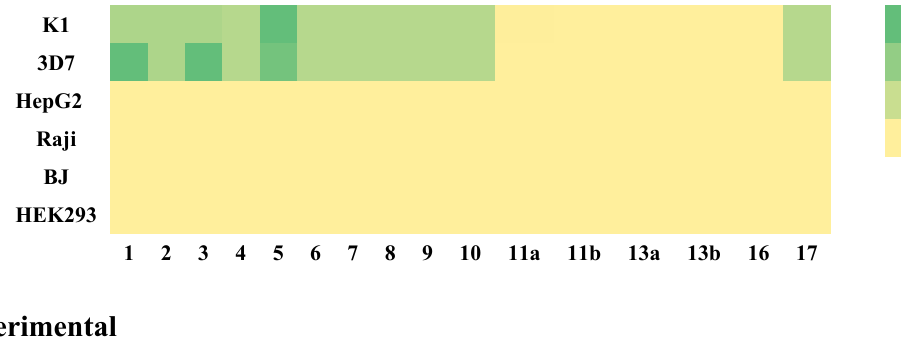
Figure 4. Anti-malarial heat map of compounds 1 – 17 and cytotoxicity